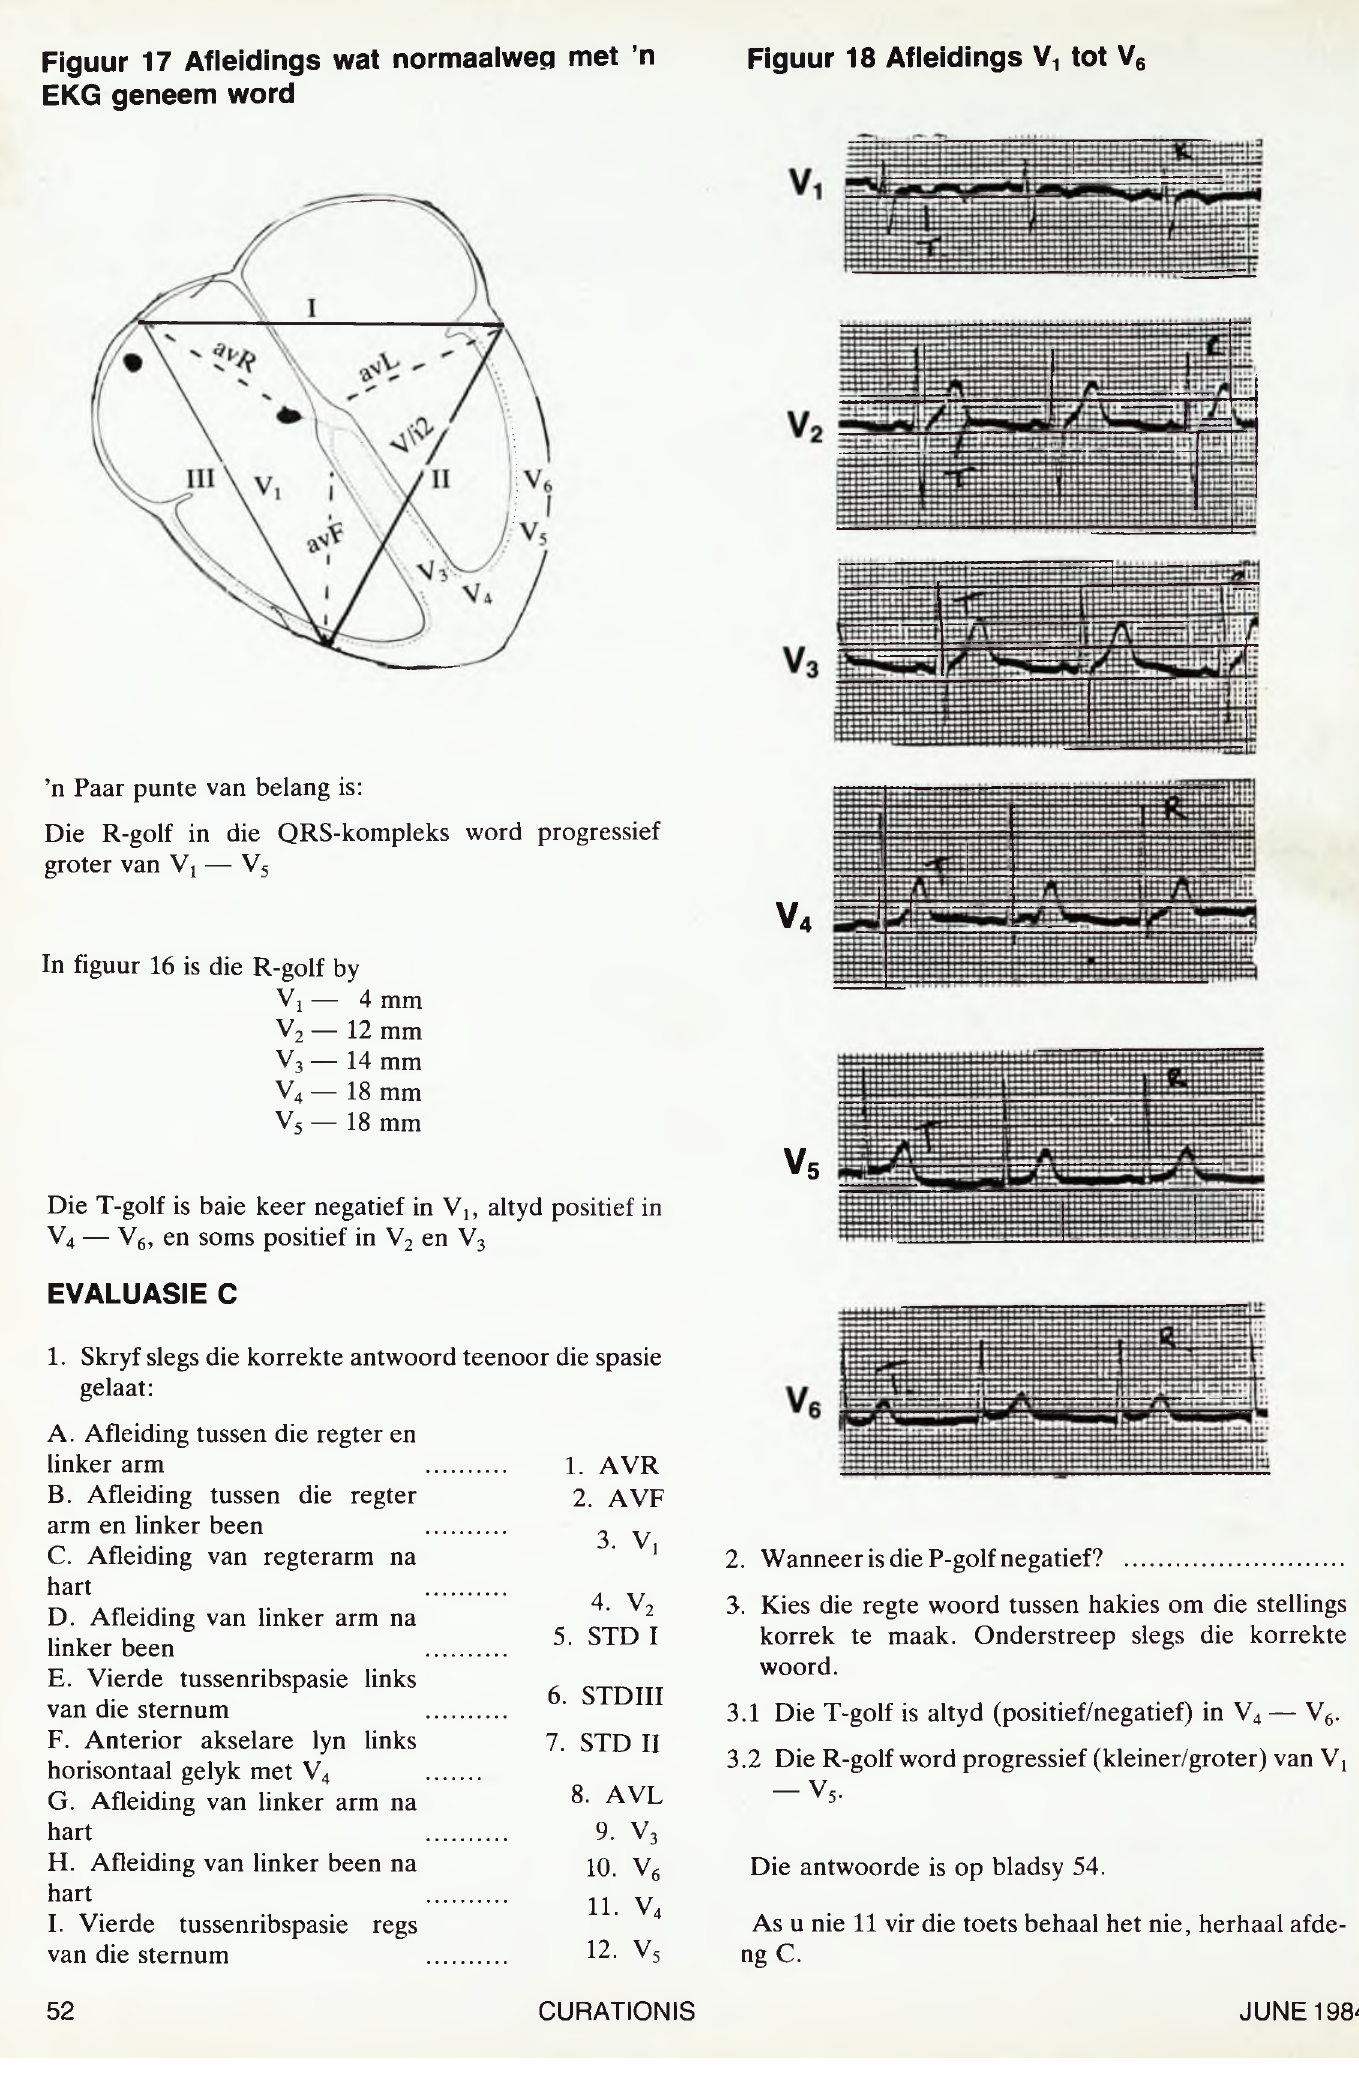
Figuur 17 Afleidings wat normaalweg met ’n EKG geneem word